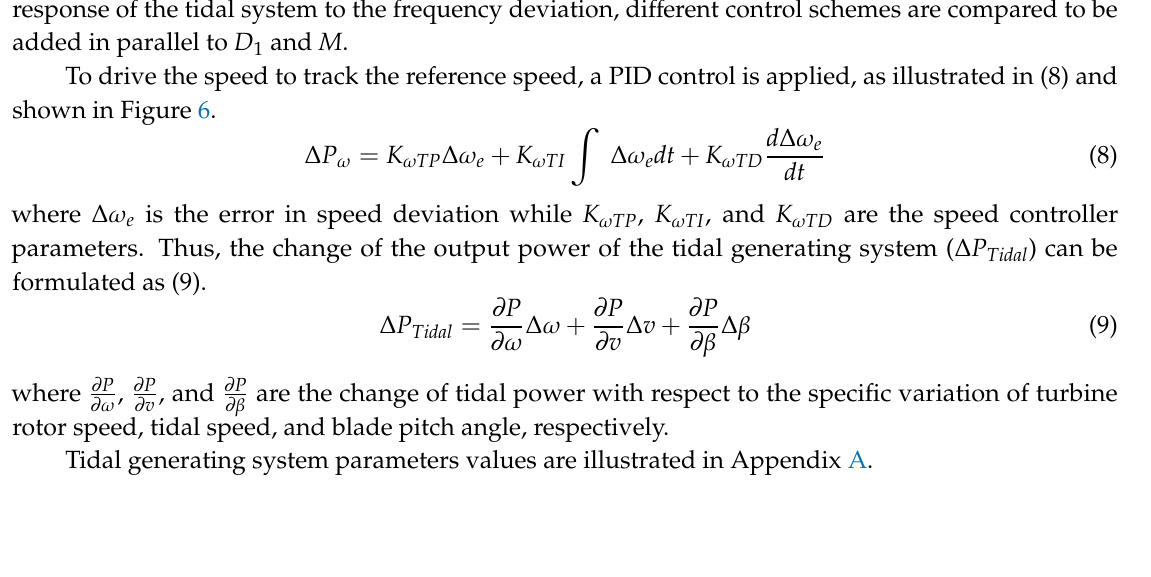
Figure 5. Tidal generation system model.